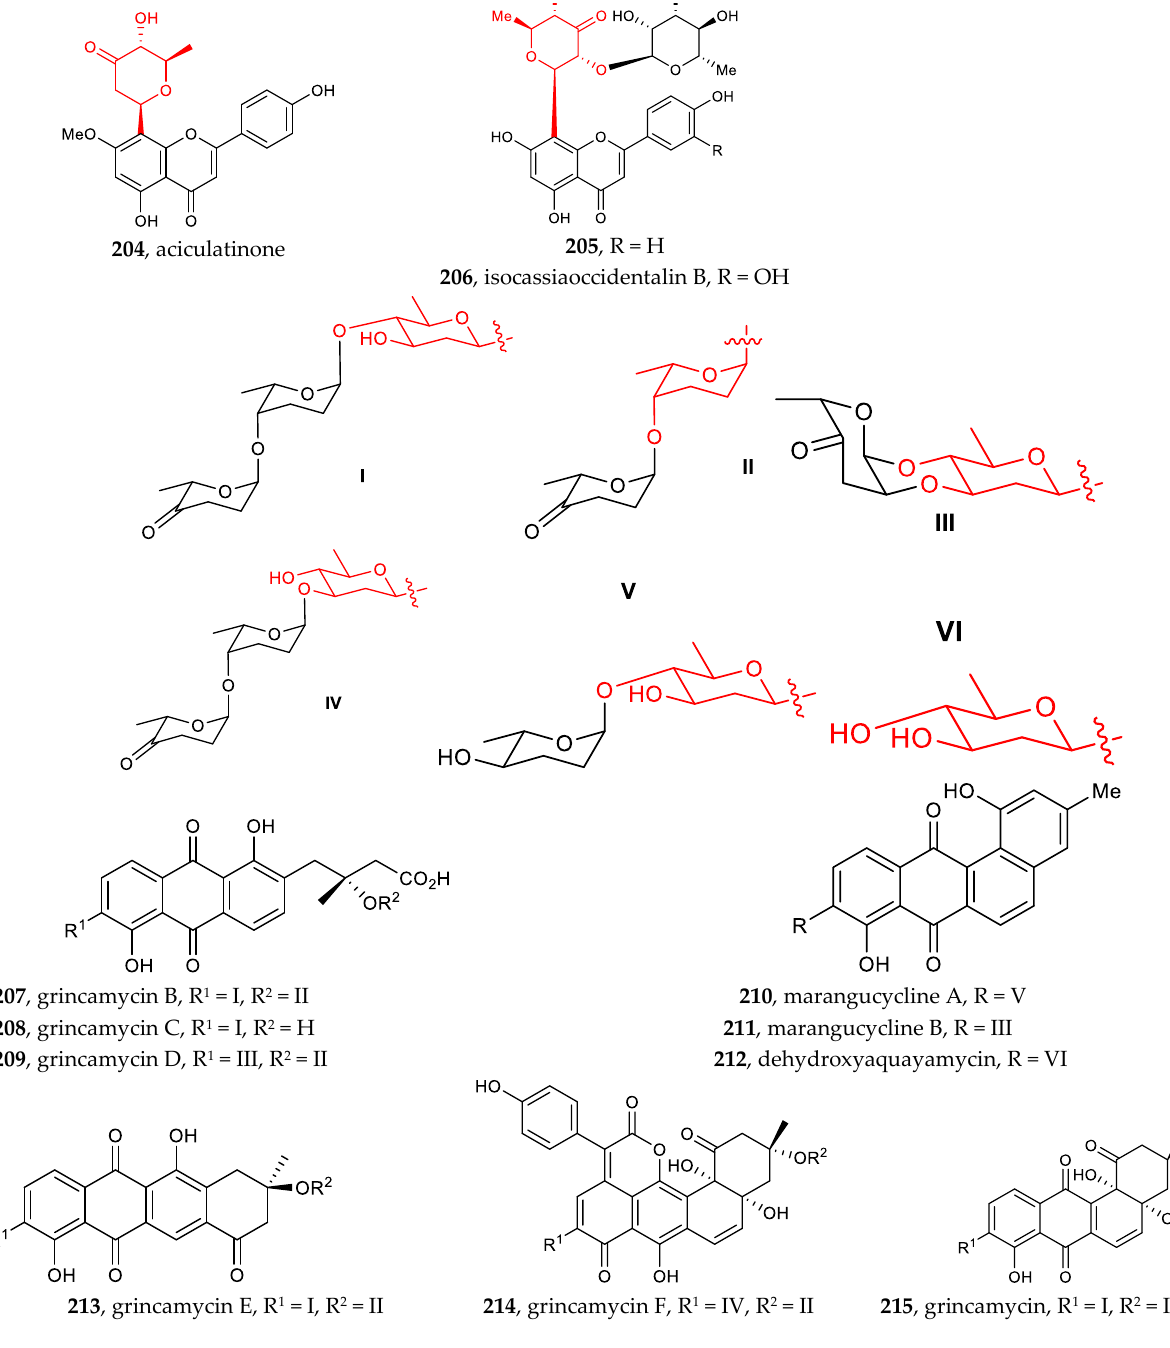
Figure 7. Chemical structures ( 188 – 215 ) of aryl C -glycosides.